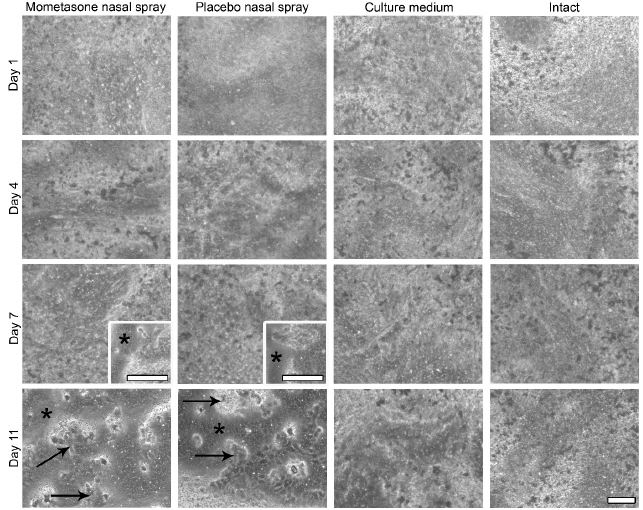
Figure 3. Morphological assessment of the nasal MucilAir TM in vitro models treated repeatedly with undiluted mometa- sone or placebo nasal spray, culture medium treated or untreated using phase-contrast microscopy. The apical surface view is shown. Cell shedding is observed in the undiluted mometasone- and placebo-treated nasal MucilAir TM in vitro models, which starts at the periphery on day 7 (inserts). Cell detachment is almost complete on day 11. Asterisks indicate areas without cells; arrows indicate the remaining cells on the growth surface. Scale bars, 100 µm.